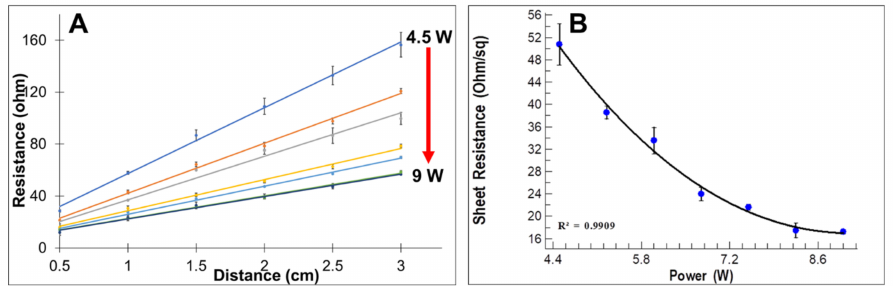
Figure 2. Optimization of electrode fabrication parameters for 10 cm/s CO 2 speed: ( A ) resistance of LIG electrodes fabricated with different CO 2 powers; ( B ) respective sheet